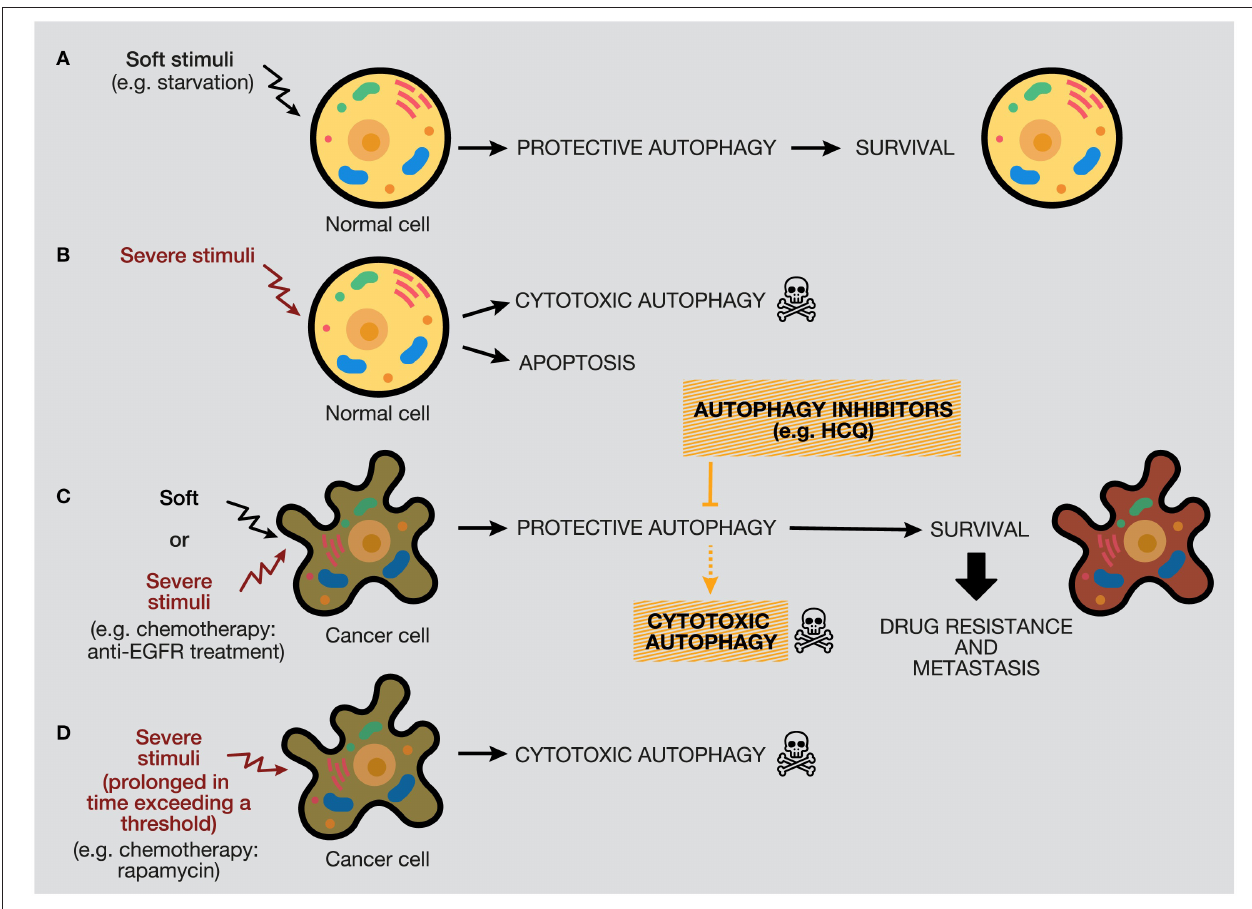
FIGURE 6 | Distinctive responses of normal and cancer cells to different stimuli. The autophagy response depends on the intensity and duration of the stimuli (external or internal), highlighting a threshold in the autophagy mechanism that would determine cellular outcome. (A) Normal cells under soft stimuli, such as starvation, will ensure their survival through protective autophagy. (B) Severe stimuli on normal cells can induce cytotoxic autophagy or apoptosis. (C) In contrast, soft or severe stimuli over cancer cells (for example, anti-EGFR treatments) will provoke protective autophagy, which will confer survival properties, drug resistance, and metastasis. In this case, the use of autophagy inhibitors would provoke cell death by autophagy or occasionally by apoptosis. (D) Last, severe stimuli able to reach a threshold can increase cytotoxic autophagy.